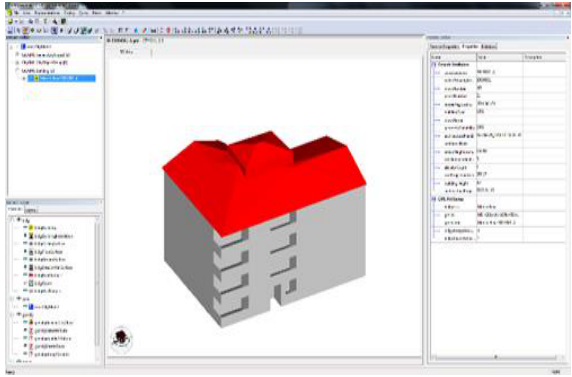
Figure 4. 3D Architectural Building.